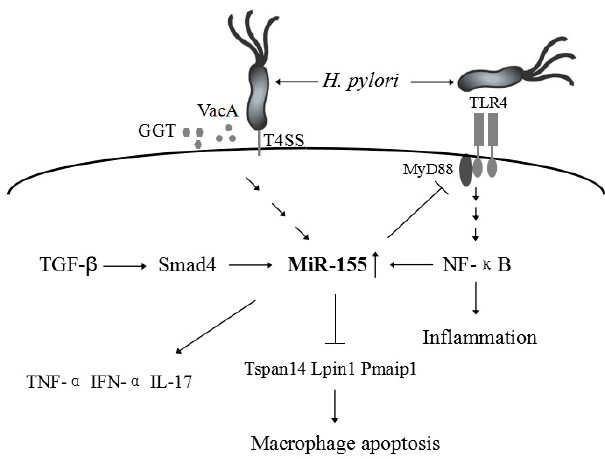
Figure 1. Overview of regulation of miR-155 by H. pylori infection.